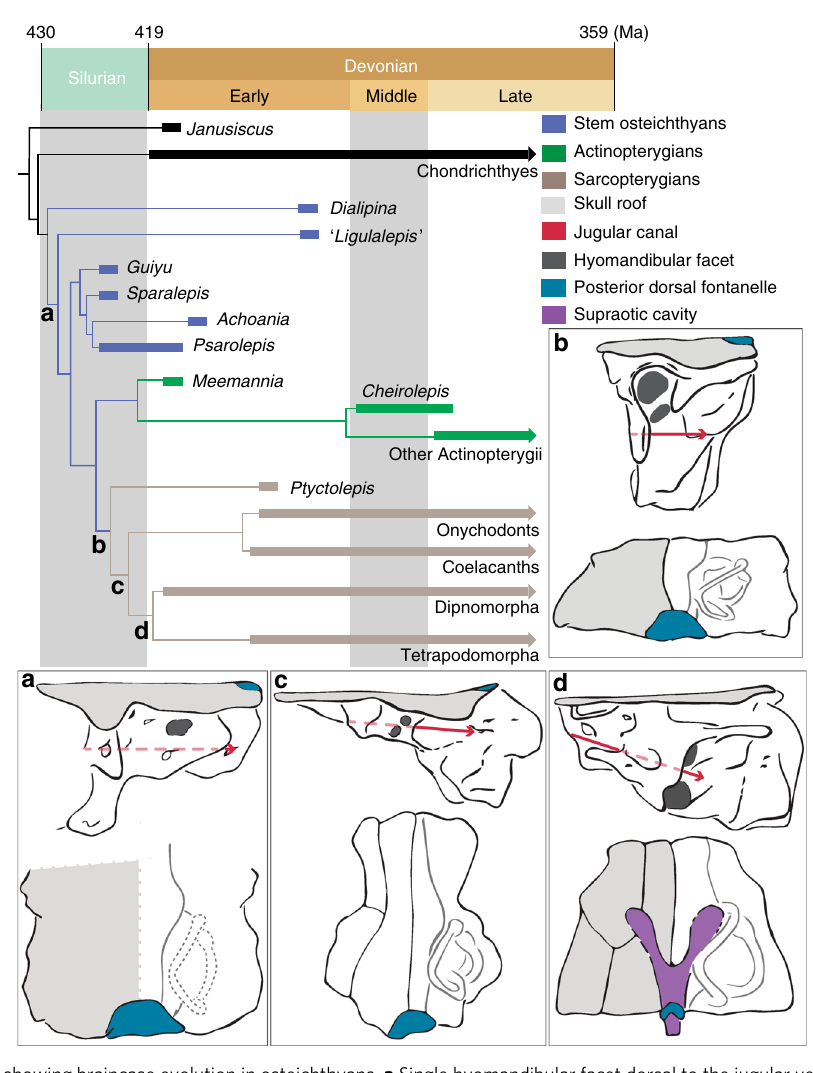
Fig. 3 Simpli fi ed phylogeny showing braincase evolution in osteichthyans. a Single hyomandibular facet dorsal to the jugular vein, as shown in ' Ligulalepis ' 13 . b Double hyomandibular facet dorsal to the jugular vein, as shown in Ptyctolepis . c Double hyomandibular facet straddling the jugular vein, as shown in Qingmenodus 22 . d Double hyomandibular facet dorsal to the jugular vein; supraotic cavity present, as shown in Eusthenopteron 40 . Not drawn to